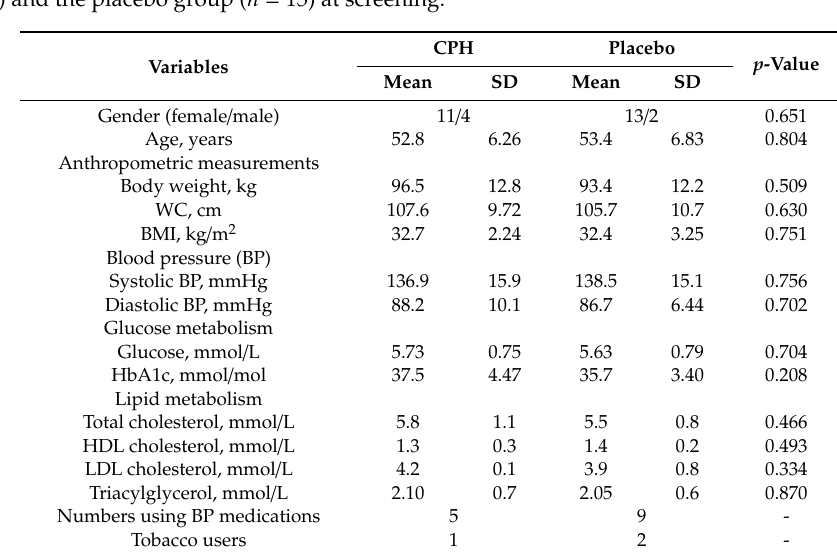
Figure 1. Overview of the participant flow during this study. Table 1. Clinical and physical characteristics of subjects in the cod protein hydrolysate (CPH) group ( n = 15) and the placebo group ( n = 15) at screening.